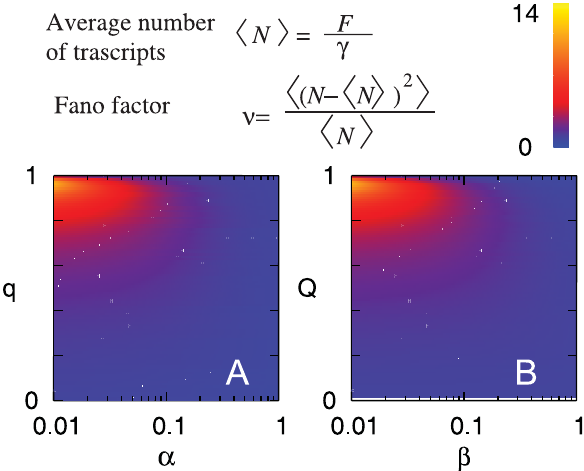
Figure 4. Parameter dependence of Fano factor. (A) Fano factor in the recruitment model for n ~ 1 z 1 { q ð Þ q { a ð Þ a z 1 { q ð Þ a z 1 { q z a ½ = S N T 1 { q { a ð Þð Þ(cid:1) Æ N æ = F / c =10. The horizontal axis shows the aspect ratio a =O 9 /E , and the vertical axis shows the recruitment probability q . The fluctuations are larger for smaller a , where the formation of the closed complex is the rate-limiting step. (B) Fano factor for the dead-end model, " # !" # { 1 z d = c )( c = d ) 2 ab 2 bc ( c = d z 1) ab 2 z (1 n ~ 1 z Q (1 { Q ) { ( b z 1 { Q ) b z 1 { Q z d ( a z 1) 2 ( a z 1) 2 ~ Q with c , for Æ N æ =10 and a =1. The horizontal axis is d S N T b z 1 { Q ð Þ b =( t O + t E )/ t dead , the ratio of the average time required for successful firing to the average time taken to remove a dead-end complex, and the vertical axis is the probability of successful firing, Q . Small b and large Q gives large fluctuations, which enables bust like firing through successive normal firings (from large Q ) and long silent periods until the dead-end complex is removed (from small b ). The detailed calculations are given in Text S1.